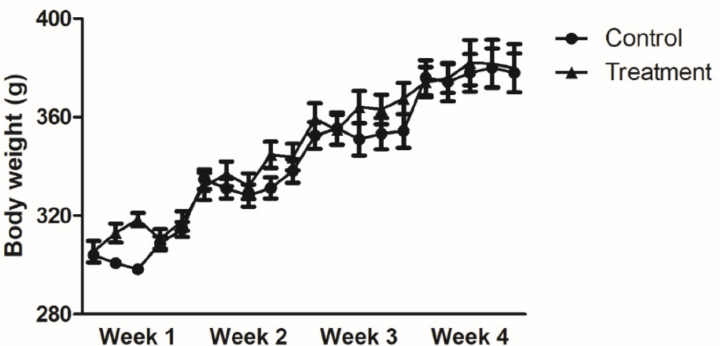
Figure 2. Change in body weight over time. Body weight increased gradually in both treatment and control group. Results are expressed as the mean ± SEM ( n = 7/group). No significant difference was observed in the body weight between the two groups (two-way ANOVA with post-testing by Bonferonni correction).